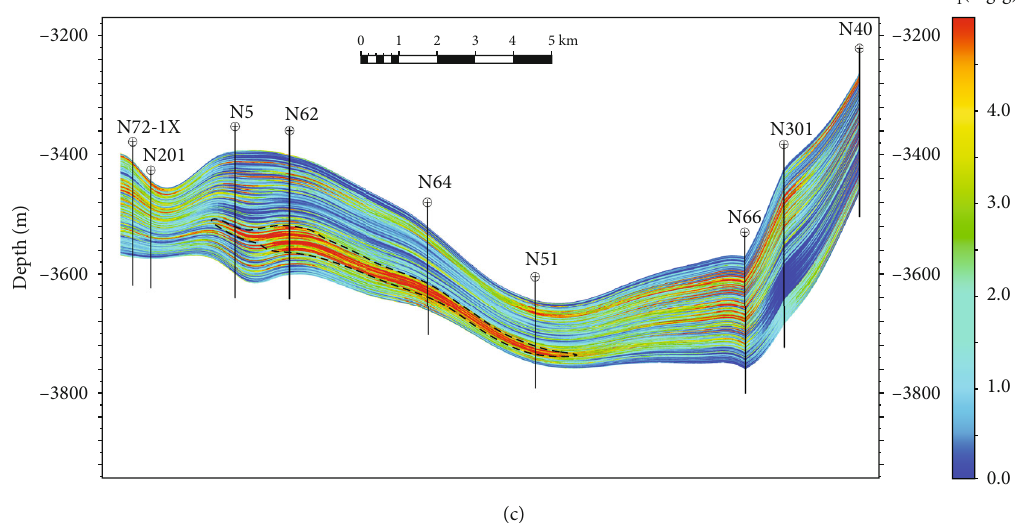
Figure 14: Pro fi le connected by wells showing the (a) brittleness index, (b) lithofacies, and (c) S